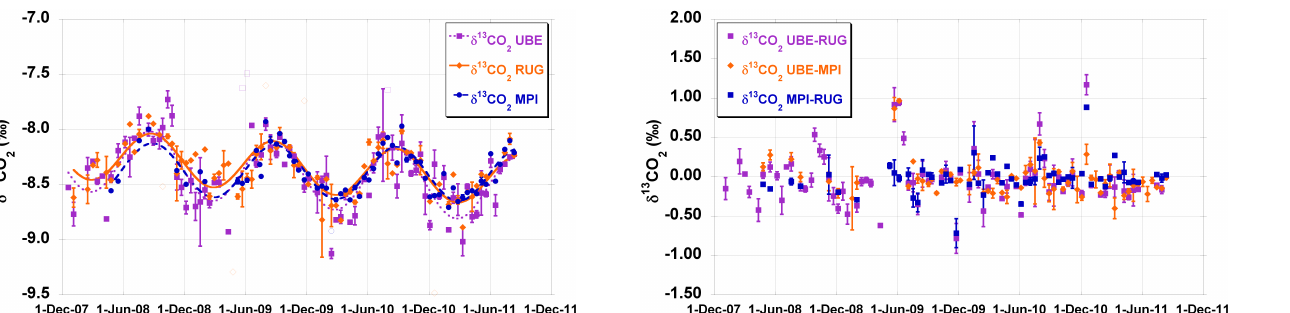
Fig. 6. δ 13 CO 2 observations from Jungfraujoch, Switzerland from flask samples measured by three laboratories: UBE (pink squares), RUG (orange diamonds) and MPI (blue circles). The values are the averages of 1, 2 or 3 flasks. The fits through the data are linear trend plus single harmonic seasonal components. Open symbols repre- sent those values that are outliers to the fit of the individual data set (based on the 2.7 sigma exclusive filter on the residuals). The error bars represent the standard error of the average value of 2 or 3 flasks. For single flask measurements error bars are not shown.